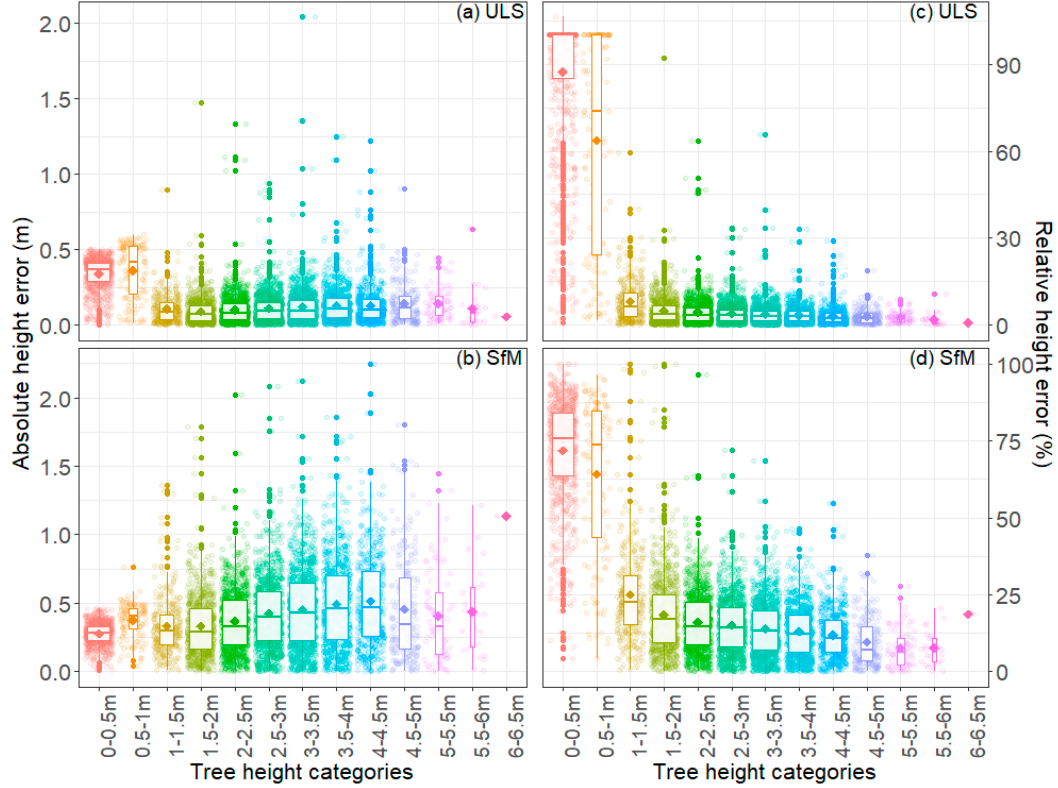
Figure 7. Variation between tree height categories in the absolute error ( a , b ) and percentage error ( c , d ) between measured values and those predicted by ( a , c ) ULS and ( b , d ) SfM. Box plots show median error for each category, along with confidence intervals. Box width represents sample size. Diamonds represent the mean error for each height class.